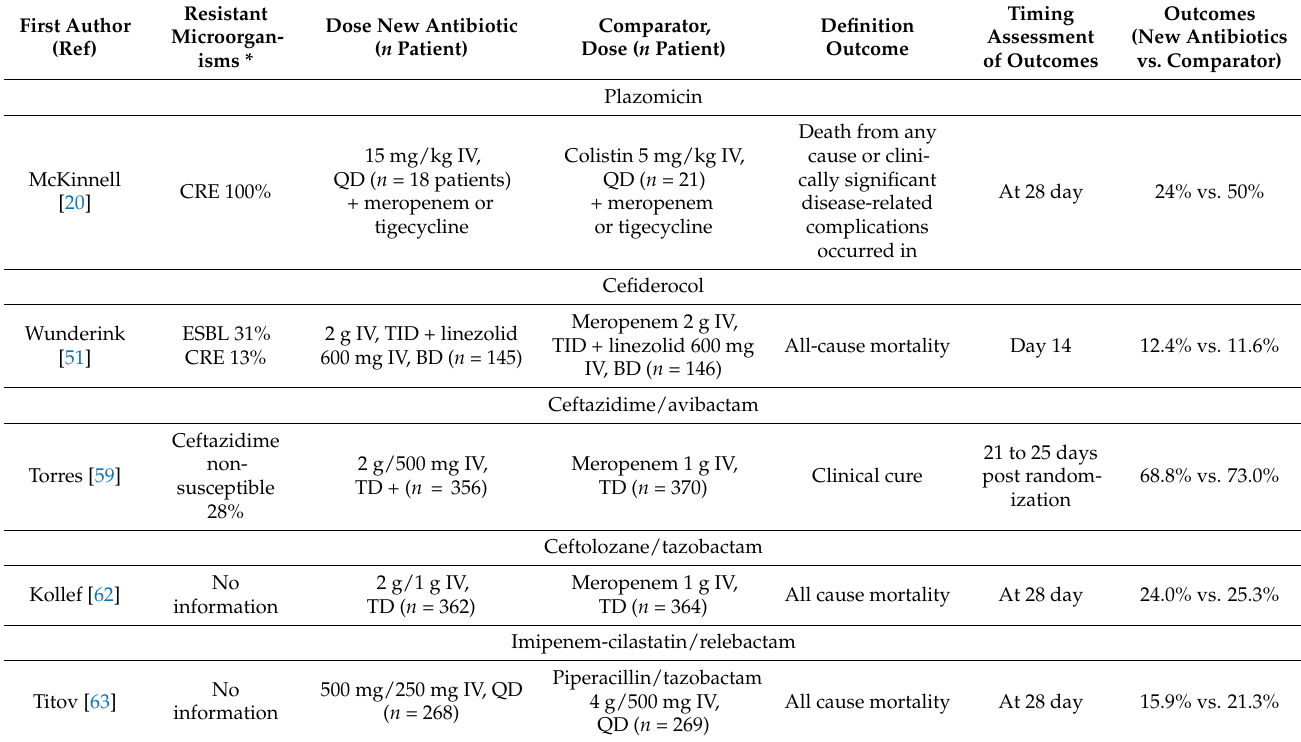
Table 3. Clinical studies on hospital-acquired or ventilator-associated